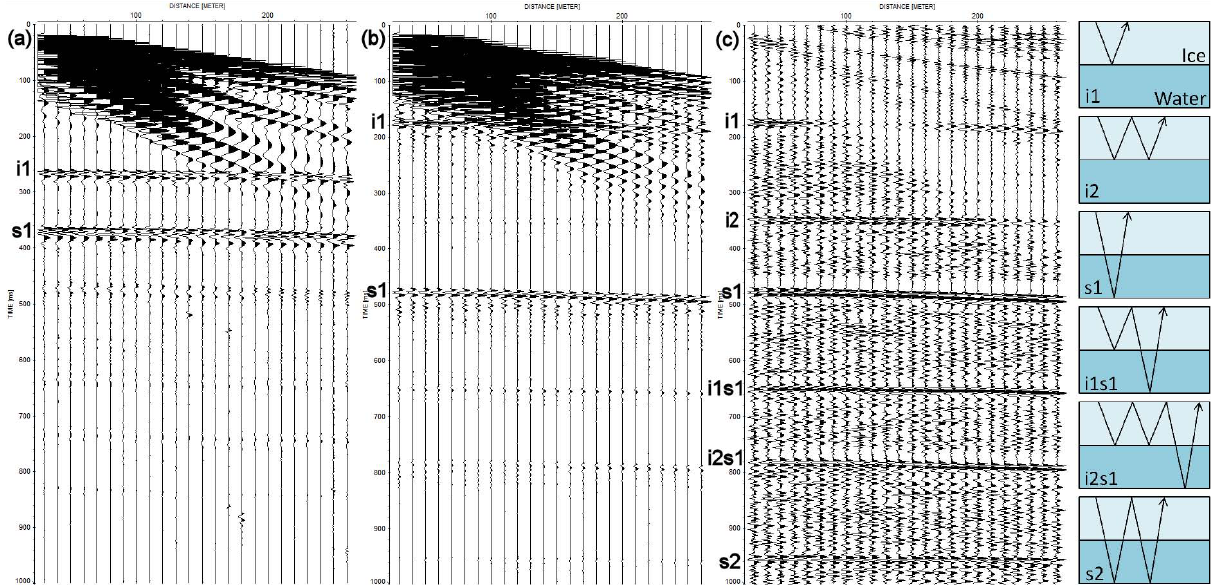
Fig. 3. Example 24-channel seismic records with multiples: (a) Raw data from a single Francis Island site with clear ice-base (i1) and seabed (s1) direct arrivals, multiples also present but weak; (b) Raw data from a single Churchill Peninsula site with clear s1 arrival but the direct ice-base arrival (i1) is obscured by groundroll noise; (c) as b but with a frequency-wavenumber filter to remove groundroll and AGC filter to enhance weaker signals. Direct reflections and multiples annotated as per the schematic. Raypaths on the schematic are for illustrative purposes only and do not represent true raypaths, which are significantly distorted by the velocity gradient of the firn layer and velocity contrast at the ice base.